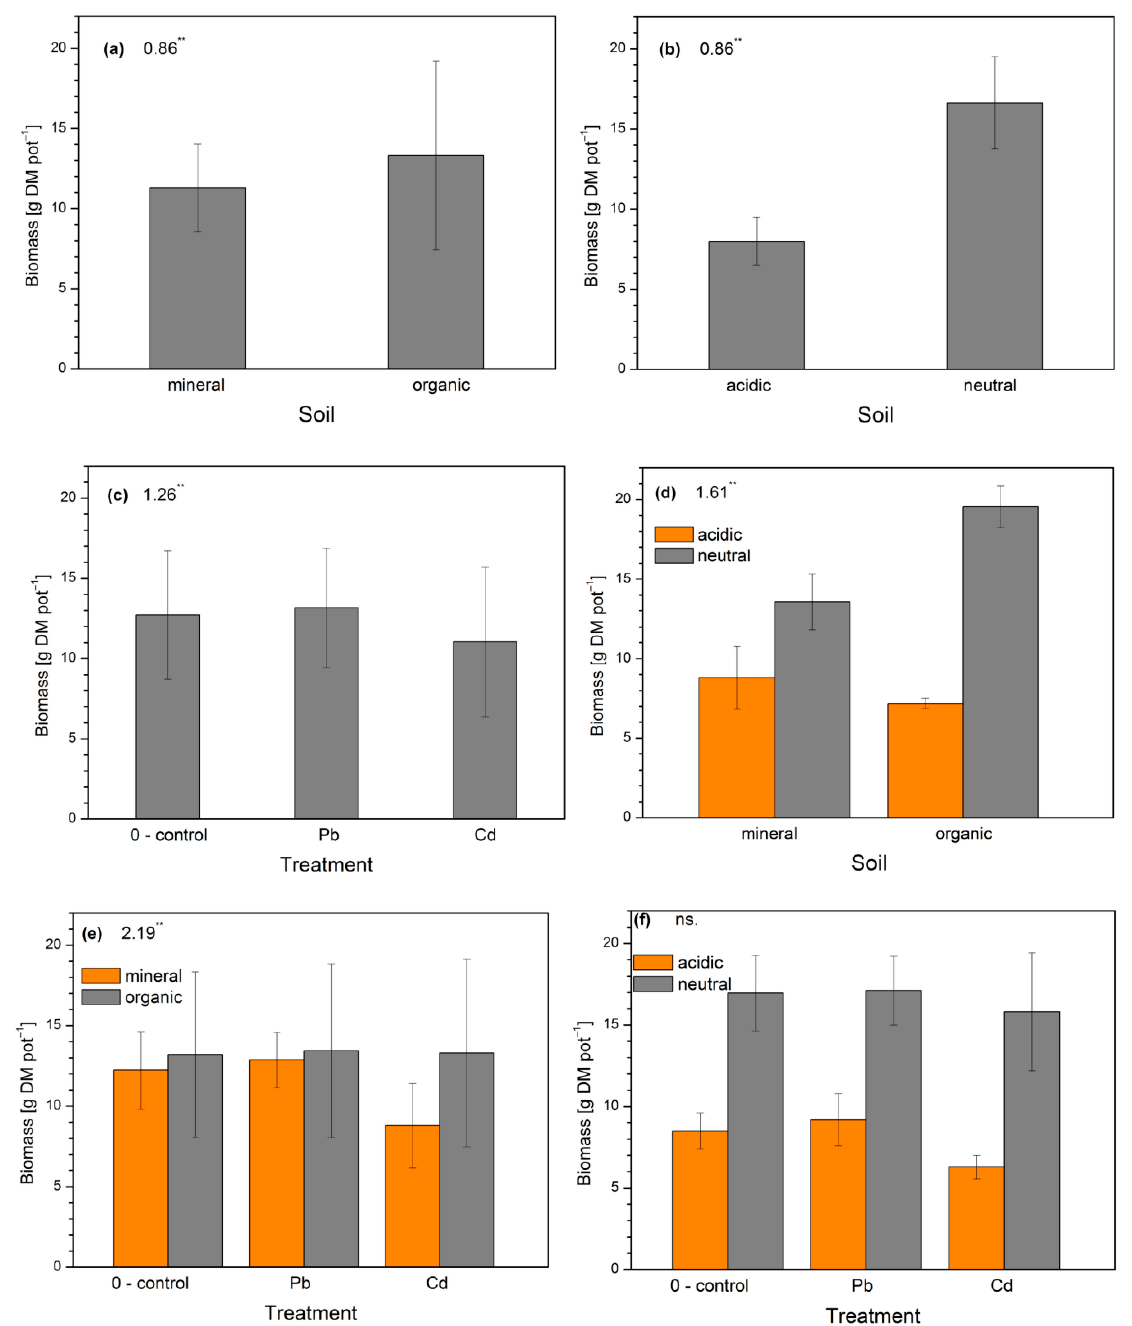
Figure 1. Mean aerial biomass of Fagopyrum esculentum (g DM pot − 1 ). ( a – f ), sequence of subfigures. LSD p = 0.01 **, ns., non-significant (A, soil; B, soil reaction; C, metal; AB, soil, soil reaction; AC, soil, metal; BC, soil reaction, metal). A 0.86 **, B 0.86 **, C 1.26 **, AB 1.61 **, AC 2.19 **, BC ns.